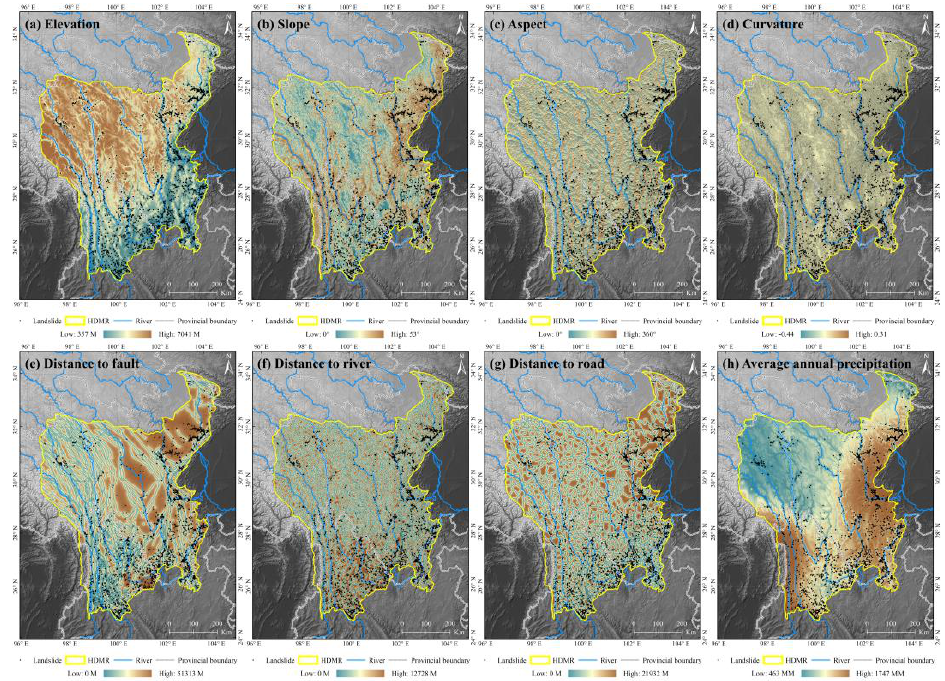
Figure 6. Predisposing factors with continuous factor values adopted in the case study. ( a ) Elevation. ( b ) Slope. ( c ) Aspect. ( d ) Curvature. ( e ) Distance to fault. ( f ) Distance to river. ( g ) Distance to road. ( h ) Average annual precipitation. Histogram equalization stretching is used in illustrations of factor values.